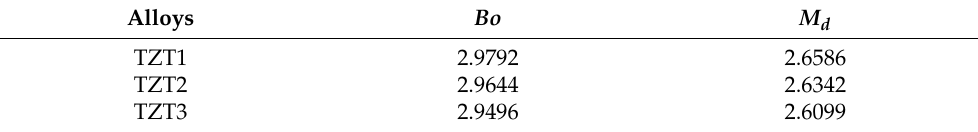
Table 1. The calculated values of B o and M d for TZT1, TZT2 and TZT3 alloys.